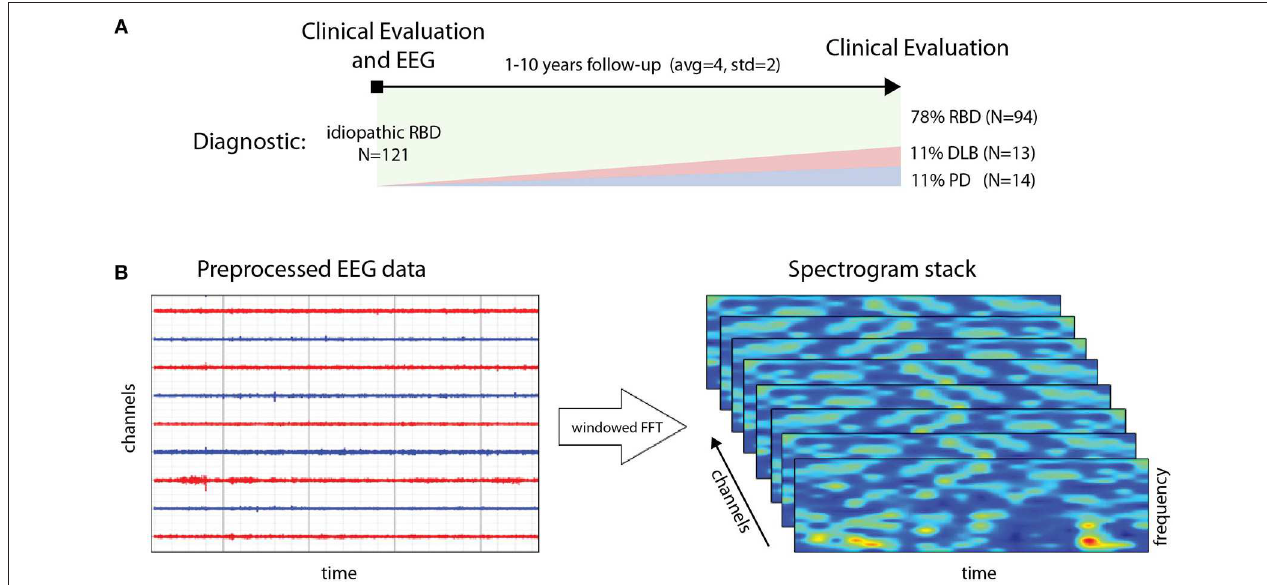
FIGURE 1 | ( A , top) Generation of spectrogram stack for each data epoch for a subject from preprocessed (artifact rejection, referencing, detrending) EEG data. ( B , bottom) Timeline and data collection study design: from diagnosis and EEG data collection to follow up with clinical evaluation for conversion to PD and DLB (or remaining idiopathic